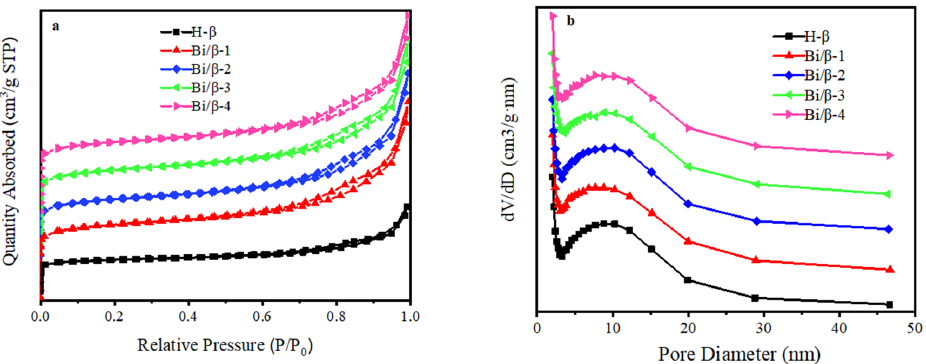
Figure 3. ( a ) N 2 adsorption–desorption isotherms of H- β and various Bi/ β catalysts, ( b ) pore size distribution curves of H- β and various Bi/ β catalysts.